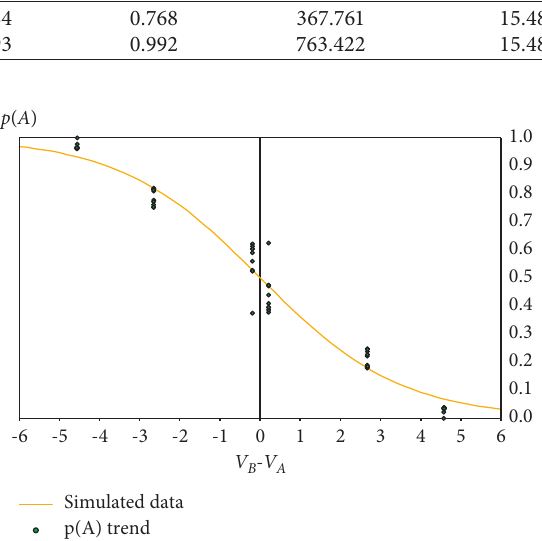
Figure 13: Trend of choice probability p ( A ) as a function of ( V